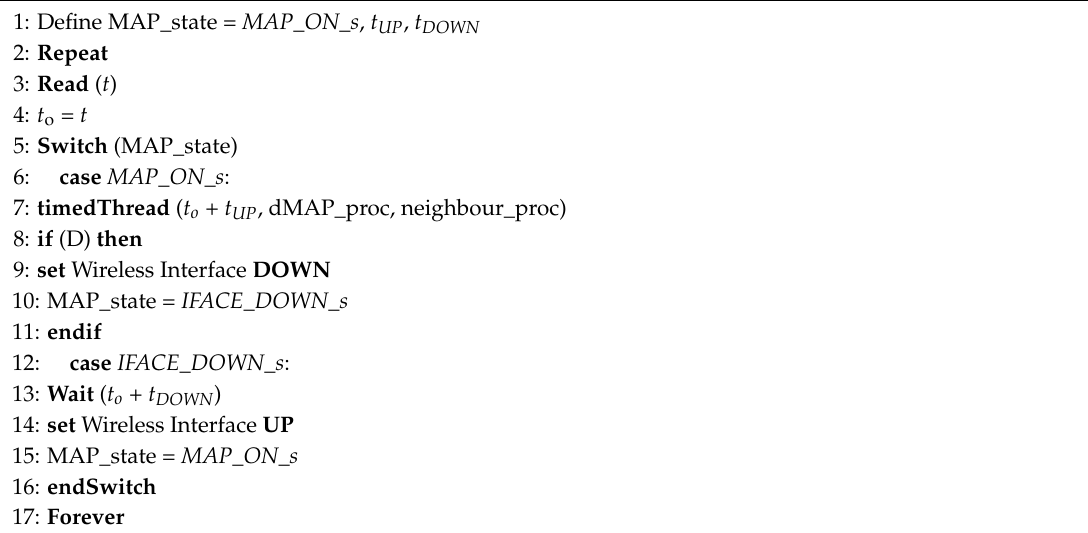
Algorithm 2: Basic Pseudocode of the dcr Main